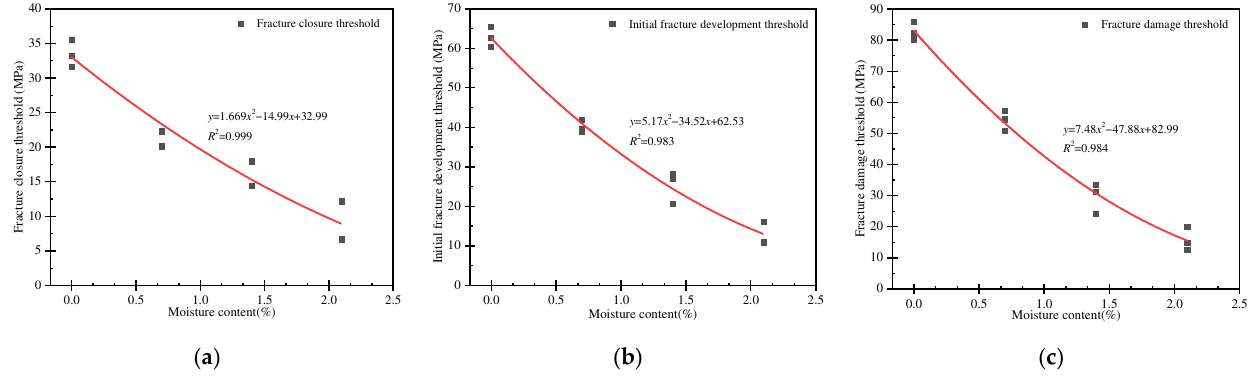
Figure 9. Stress thresholds for specimens with different moisture contents: ( a ) fracture closure threshold; ( b ) fracture initial development threshold; ( c ) fracture damage threshold. The water content significantly affected the stress thresholds at each stage, and the fracture closure threshold, initial fracture development threshold, and fracture damage threshold (corresponding to A, B, and C, respectively, in Figure 8) were approximately quadratic functions of the water content. The relatively small dispersion of the fracture closure threshold indicates that the stresses were uniformly distributed within the speci- mens, and the stresses required for fracture closure were almost the same. As the water content increased from 0% to 0.7%, the fracture closure threshold reduced by 30% from 32.99 to 23.31 MPa. The reduction in the threshold increased gradually with the increase in water content, and the threshold of the saturated rock sample reduced to 8.87 MPa, which is 27% of the threshold of dry rock sample. This indicates that the lubricating and softening effects of water inside the specimen promote the transfer of stress in the speci- men at the initial stage of loading, which causes fracture closure to occur at a lower stress state. The initial development threshold of fractures represents the end of the elastic stage of the specimen and the beginning of the fracture stable development stage. With the in- crease in water content, the initial development threshold of fracture decreased and the percentage decrease increased gradually. The initial fracture development threshold de- creased from 62.53 MPa in dry rock samples to 12.83 MPa in saturated rock samples, and